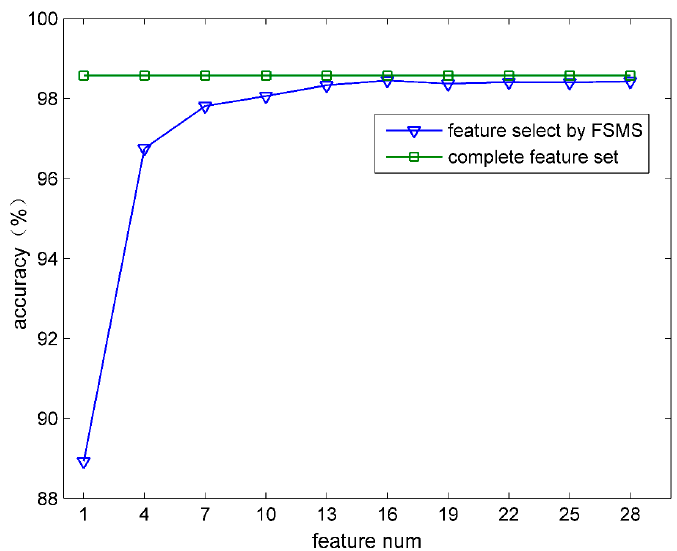
Figure 2. Accuracy comparison.